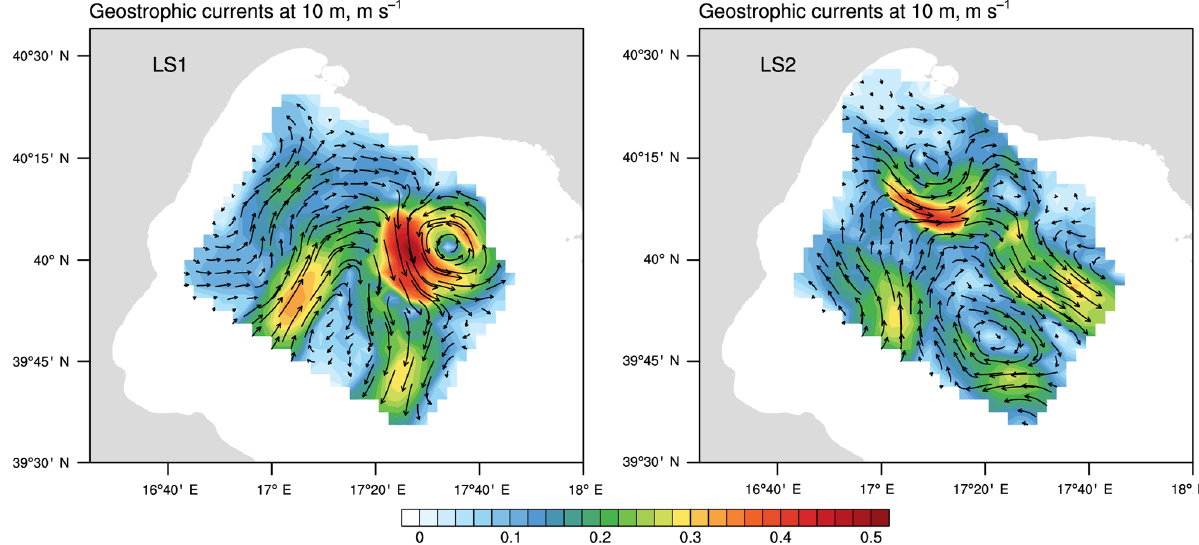
Figure 15. Geostrophic current velocities at 10m with respect to 100m for LS1 (left top panel) and LS2 (right top